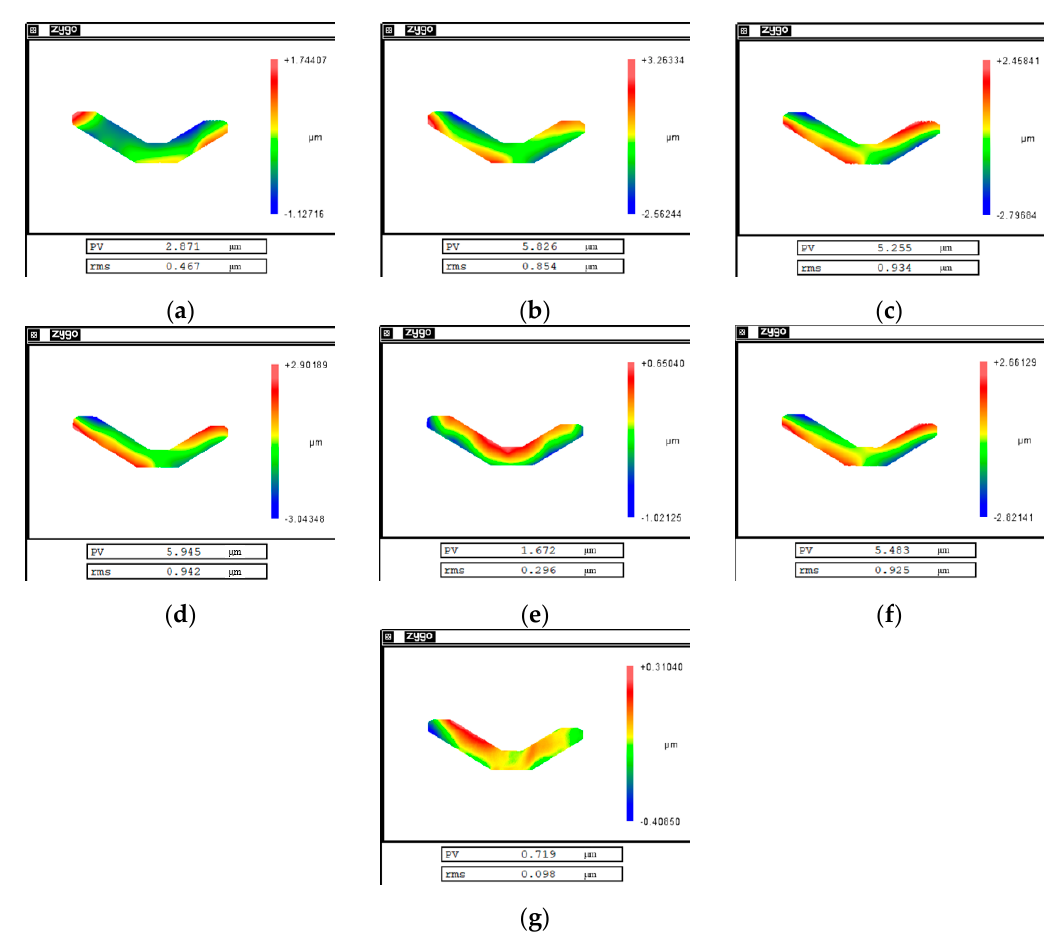
Figure 15. Experimental results: ( a ) is the measurement result before clamping; ( b ) is the measurement result after clamping; ( c ) is the elastic deformation error; ( d ) is the measurement result after the first machining; ( e ) is the cutting error; ( f ) is the measurement result after the second machining; and ( g ) is the final measurement result after disassembling the mirror.